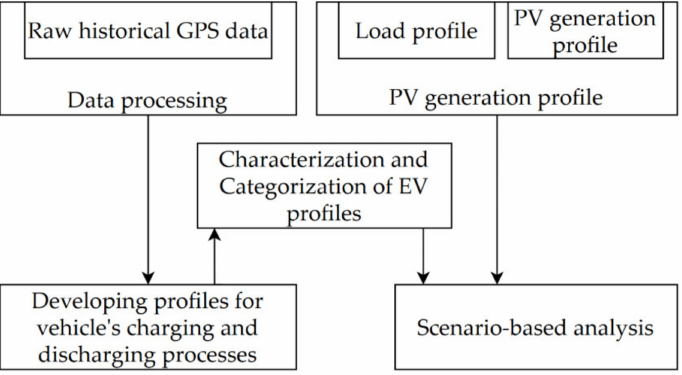
Figure 3. A multi-criteria EV modeling